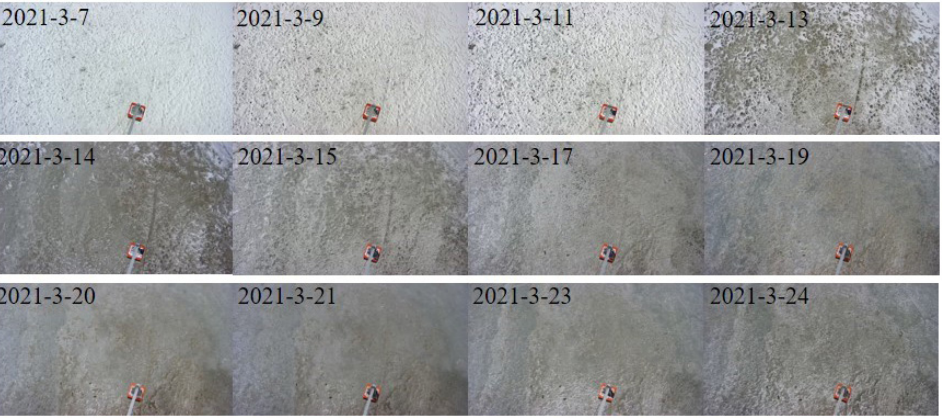
Figure 5. Photographs of the ice surface below the GPR ice thickness monitoring system.